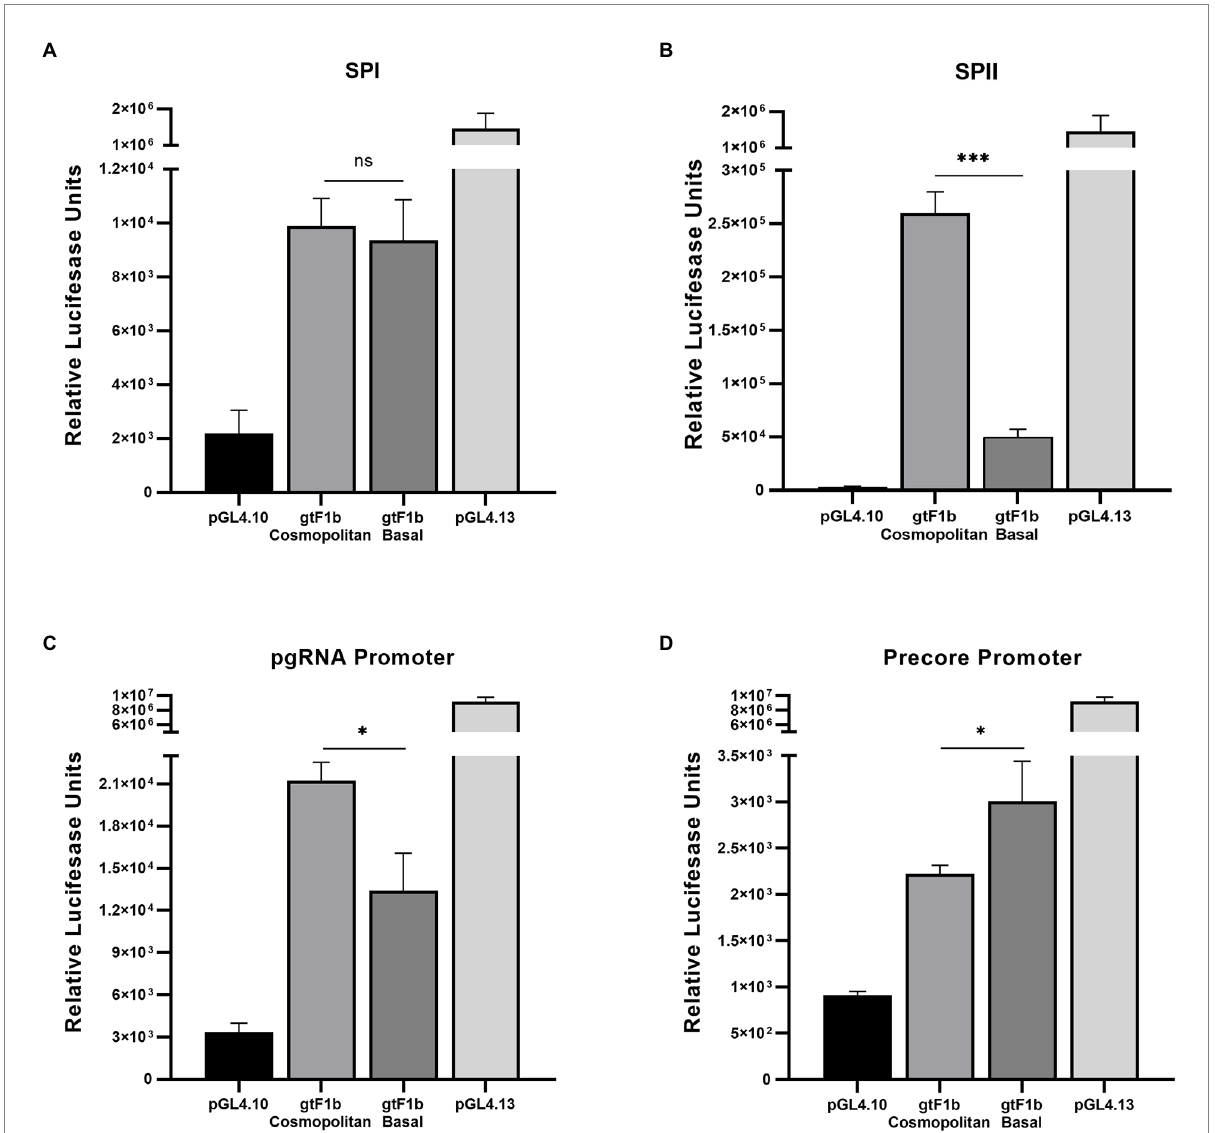
FIGURE 6 Analysis of HBV promoter activities of gtF1b Cosmopolitan and gtF1b Basal variants. HuH-7 cells were transfected with luciferase reporter constructs containing SPI (A) , SPII (B) , Core promoter with Precore TATA box-like mutated sequence (C) , and Core promoter with pgRNA TATA box-like mutated sequence (D) of gtF1b Cosmopolitan and gtF1b Basal variants. Three days’ post-transfection, cells were harvested, and luciferase activity was detected. Values shown represent the mean ± standard deviation of three independent experiments. The pGL4.13[luc2/SV40] and pGL4.10[luc2] vectors were included as positive and negative controls, respectively. * p < 0.05; *** p < 0.0001; ns: no statistical